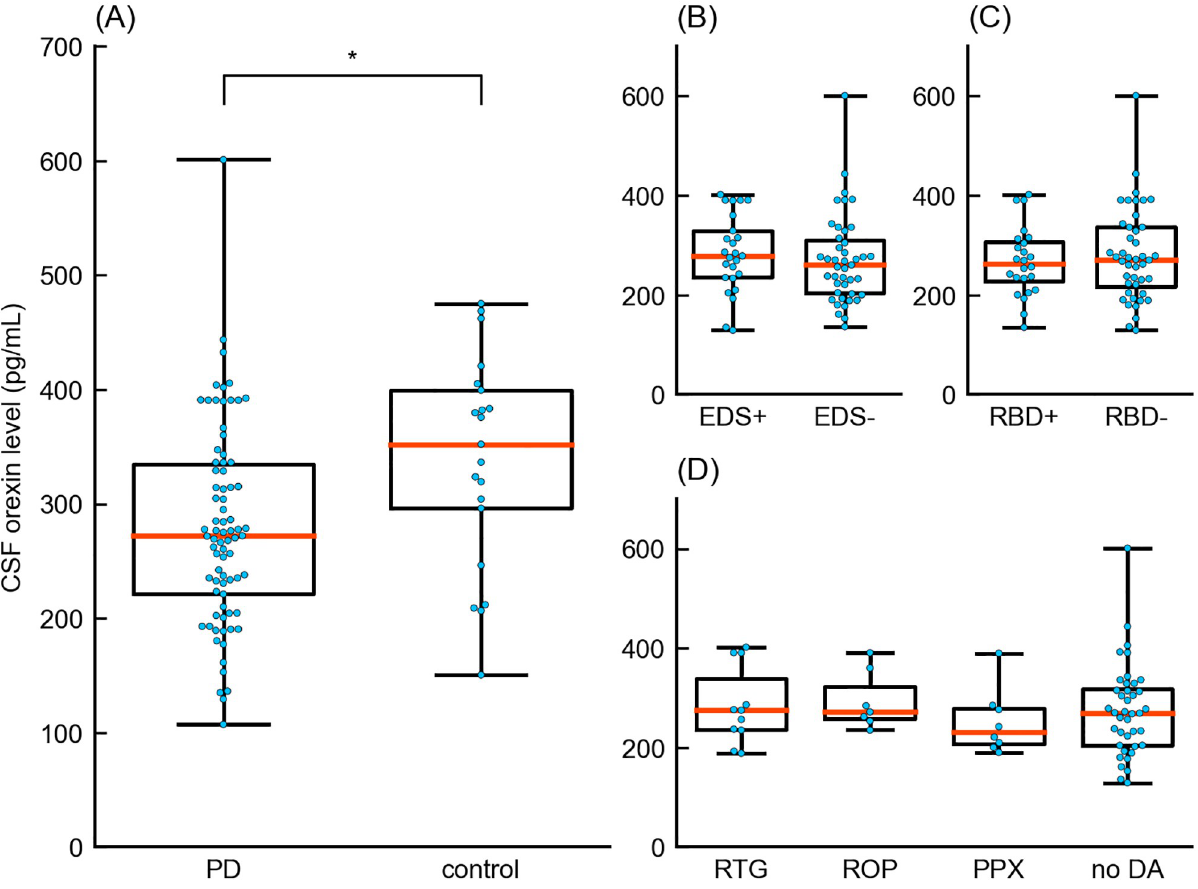
Fig 2. Boxplot of CSF orexin levels. Boxplots showing the comparison between (A) the PD and control group, (B) EDS+ and EDS- group, (C) RBD + and RBD- group, and (D) RTG, ROP, PPX and no DA groups. PD, Parkinson’s disease; EDS, excessive daytime sleepiness; RBD, rapid eye movement sleep behavior disorder; RTG, rotigotine; ROP, ropinirole; PPX, pramipexole; no DA, no use of dopamine agonist; CSF, cerebrospinal fluid. � Significant differences were observed between the PD and control groups.